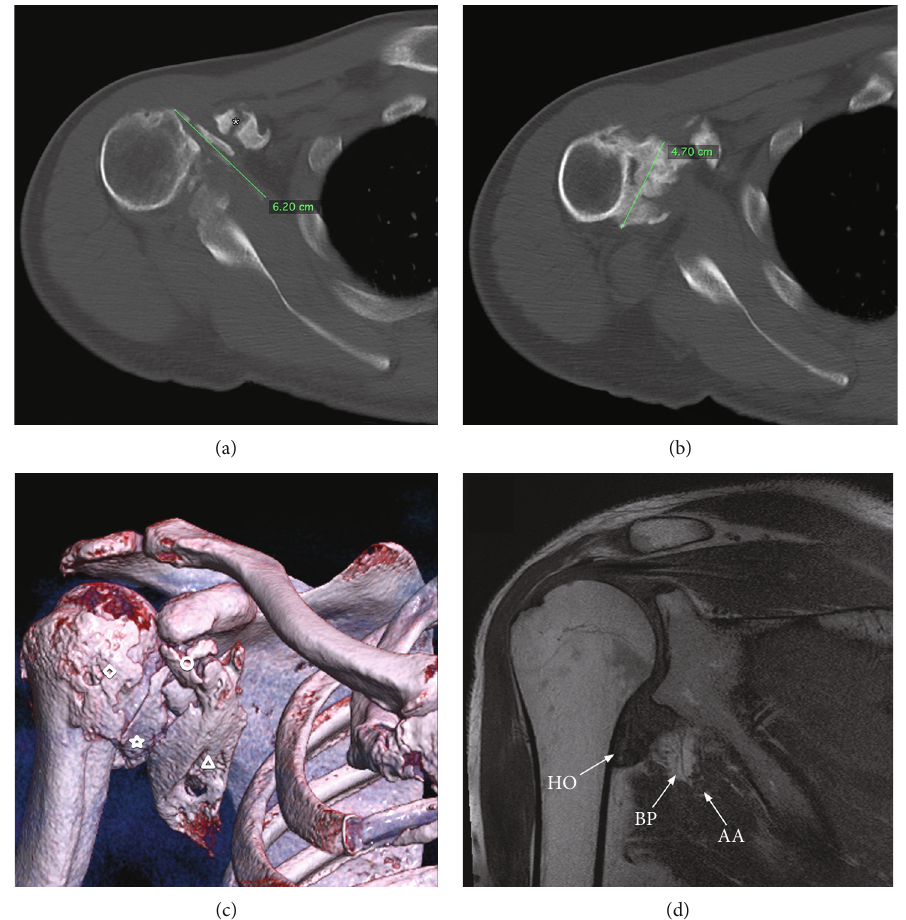
Figure 1: (a – d) 9 months after traumatic anterior dislocation, preoperative CT and MRI images demonstrating severe HO. (a) HO along the bony insertion and ventral side of the subscapularis muscle (green line) and around the conjoint tendons (asterisk) in the axial CT plane. (b) HO extending from the inferior glenoid to the proximal humeral shaft and axillary recess in axial CT plane. (c) 3D CT scan showing the extent of HO, primarily in the ventral part of the subscapularis muscle (triangle), in the axillary recess (asterisk), conjoint tendons (circle), and ventrally of the proximal humerus (diamond). (d) MRI demonstrating close location of the HO (HO) and both axillary artery (AA) and nerves of the brachial plexus